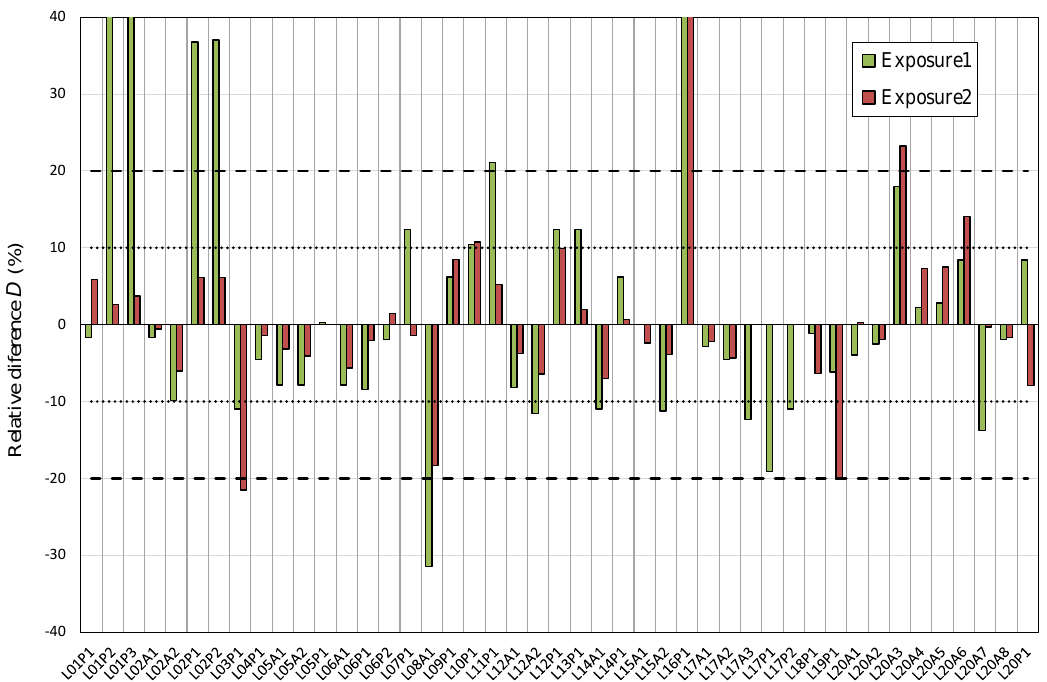
Figure 7. Relative di ff erence of participant’s results to the mean value for the first and second exposure. Intervals established for the first exposure ( ± 20%) and second exposure ( ± 10%) are indicated. In some cases, the value is out of scale in order to improve the graph view.